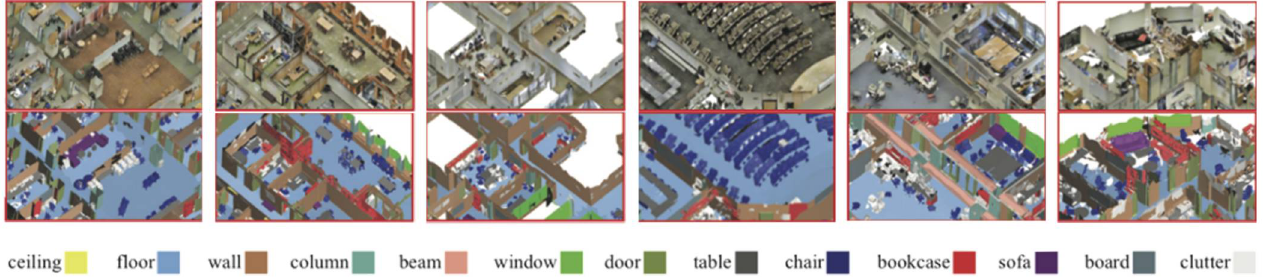
Figure 3. Stanford Large-Scale 3D Indoor Spaces Dataset (S3DIS)